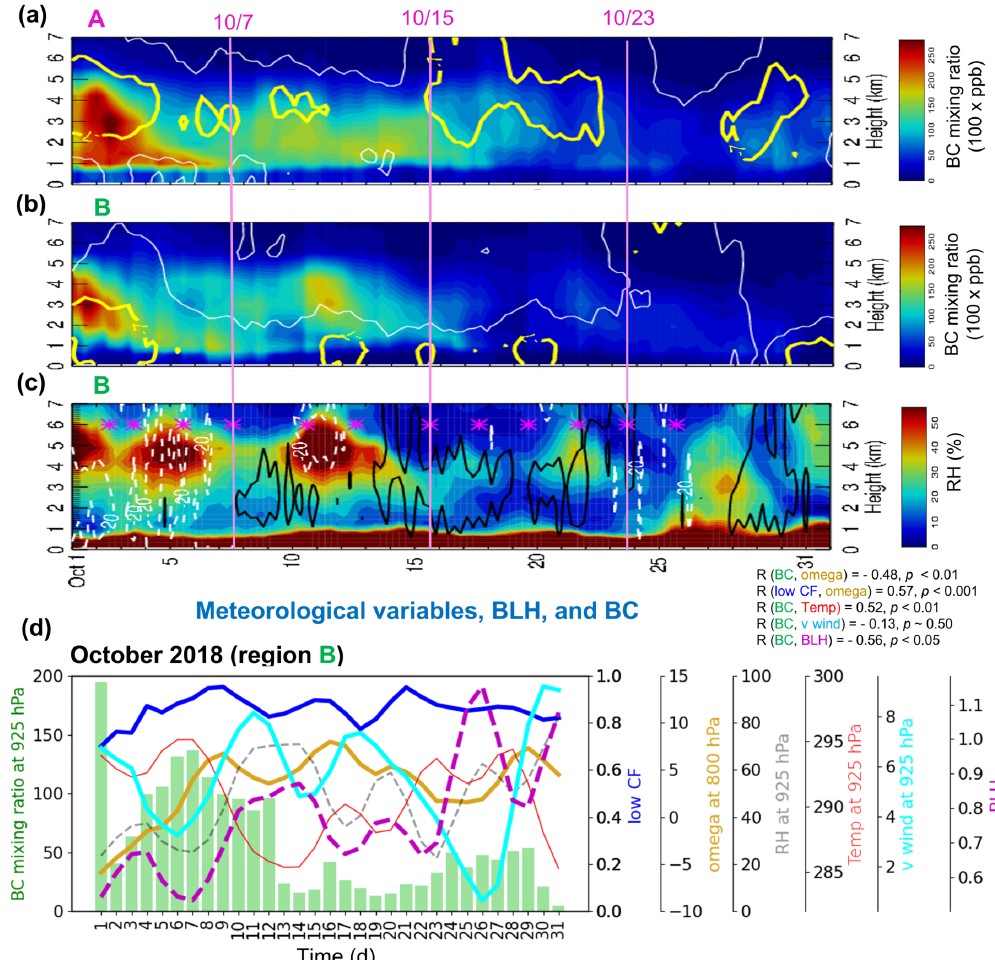
Figure 14. (a, b) Time–altitude cross section of every 6h of BC (shading; ppb × 100) overlaid by zonal wind isotachs at − 7 and 0ms − 1 (thick yellow and thin white lines, respectively) averaged over (a) region A (0–10 ◦ E, 5–15 ◦ S) and (b) region B (0–10 ◦ E, 15–25 ◦ S) in October 2018 for every 6h. (c) The same as panel (b) but for every 6h of RH (shading; %) overlaid by vertical velocities of − 20 and 50hPad − 1 (dashed white and solid black lines, respectively; positive values represent subsidence) averaged over region B every 6h. (d) Time series of daily mean 925hPa BC (green bar; ppb × 100), 800hPa vertical velocity (omega; ω ; gold line, hPad − 1 ), 925hPa RH (dashed gray line; %), 925hPa temperature (solid red line; K), 925hPa meridional wind (solid cyan line; ms − 1 ), BLH (dashed magenta line; km), and low CF (blue line) over region B. Each color line represents 3d running mean. The asterisk in panel (c) represents the October 2018 flight days. The pink solid lines in panels (a) – (c) refer to the 3 flight days. R in panel (d) refers to the Pearson correlation coefficient between two variables in parenthesis with its statistical significance ( p